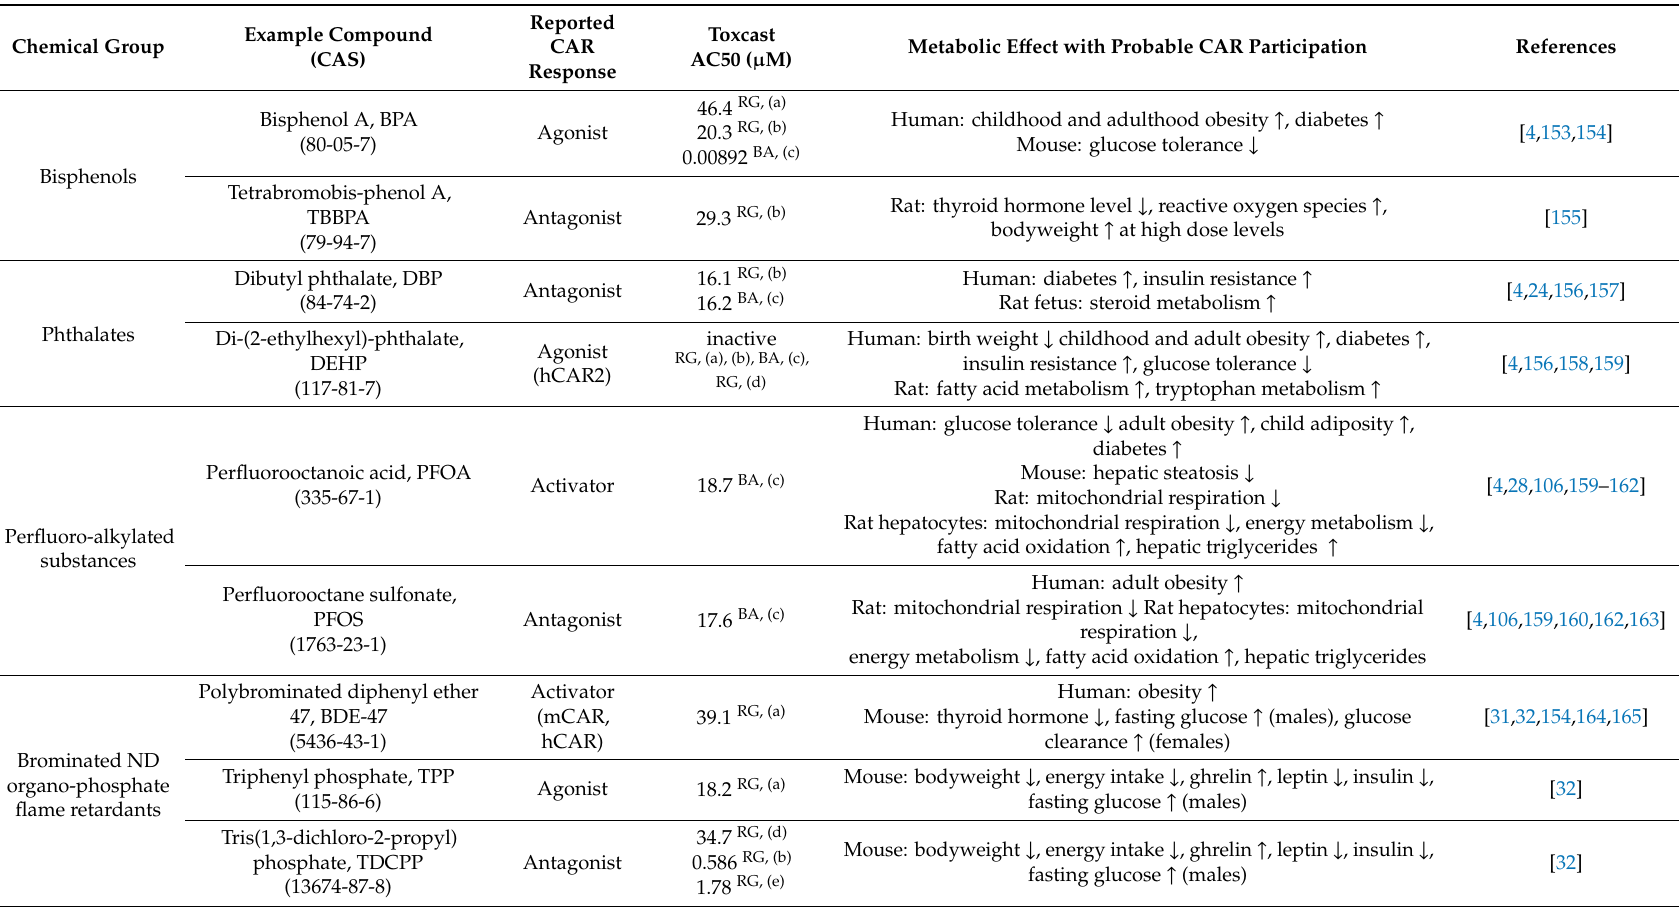
Table 2. Examples of CAR related chemicals and their proposed metabolic e ff ects via